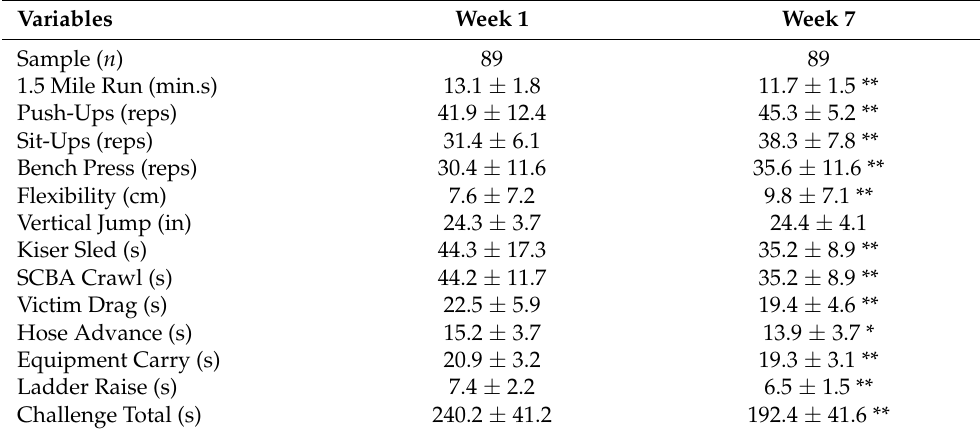
Table 2. Participant Fitness and Firefighting Ability Statistics at Weeks 1 and